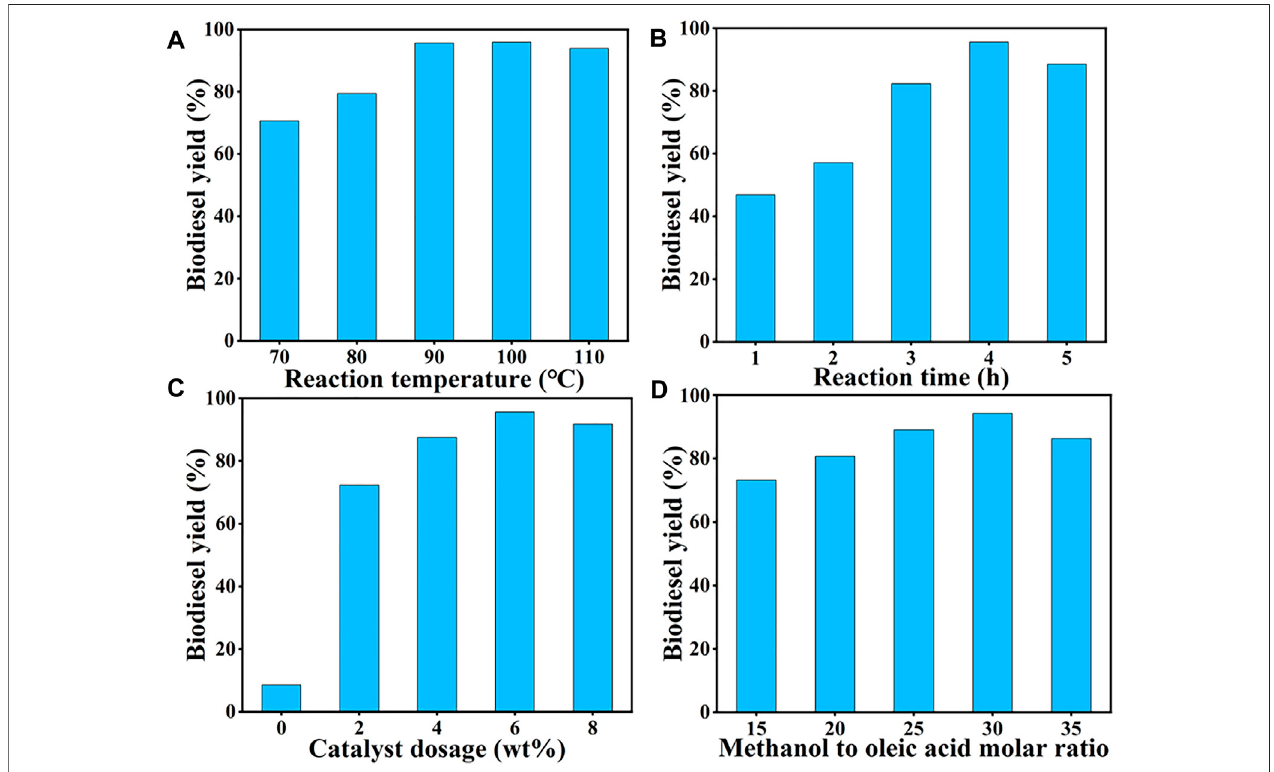
FIGURE 3 | Single-factor optimization of SiO 2 @Cs-SO 3 H catalyst for oleic acid esteri fi cation reaction: (A) reaction temperature, (B) reaction time, (C) catalyst dosage, and (D) methanol to oleic acid molar ratio.